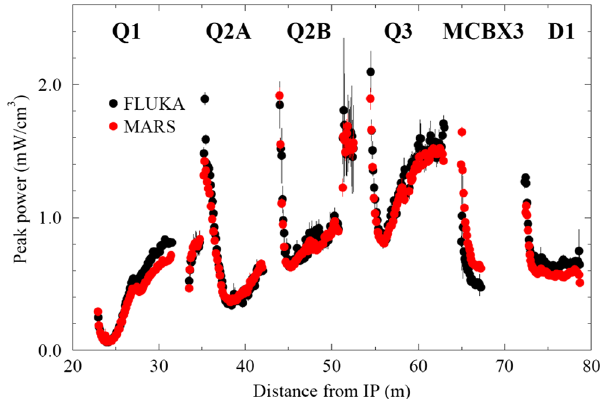
FIG. 10. Longitudinal peak dose profile (bottom) on different segments of the beam screen